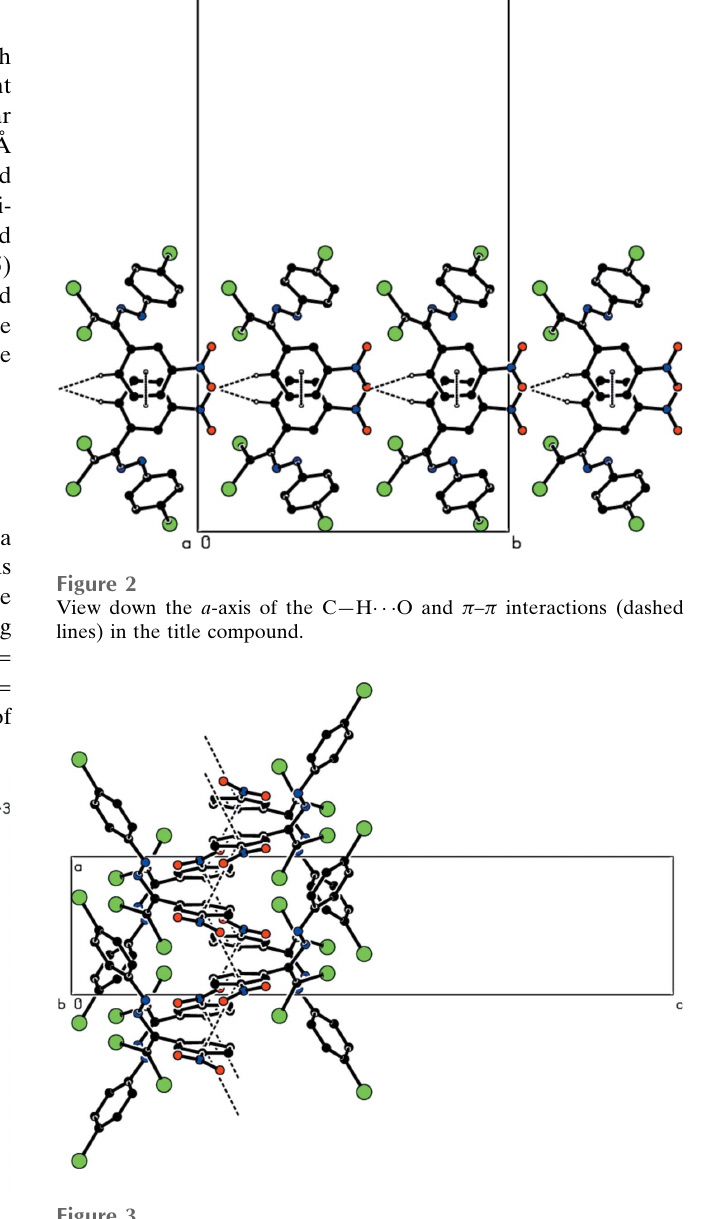
Figure 1 The molecular structure of the title compound. Displacement ellipsoids are drawn at the 50% probability level.